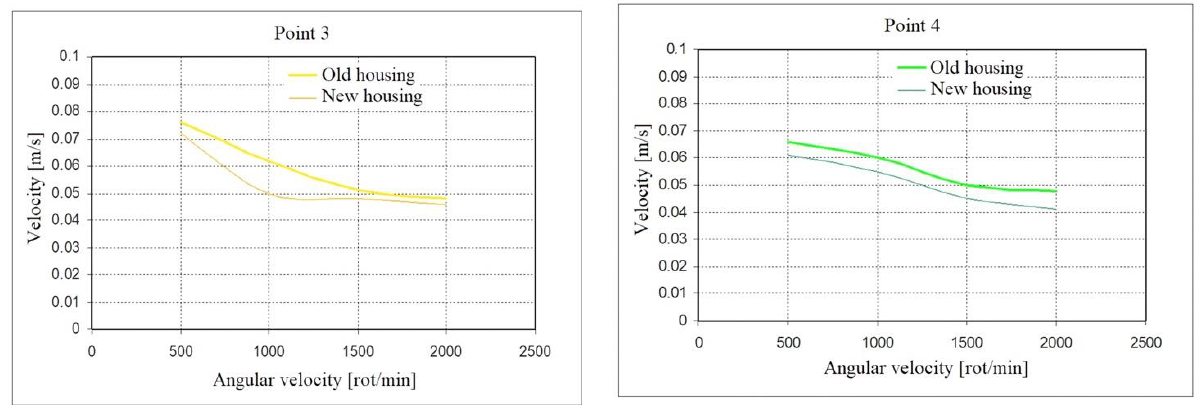
Figure 24. The velocities determined at points 1 and 2 of the two adder boxes (old and new version).